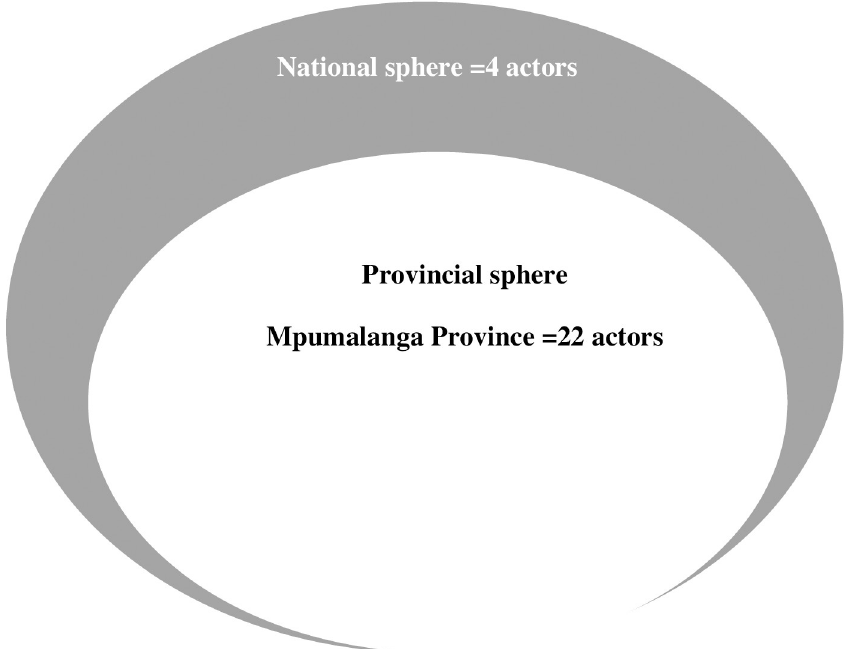
Fig 2. Overview of Mpumalanga province